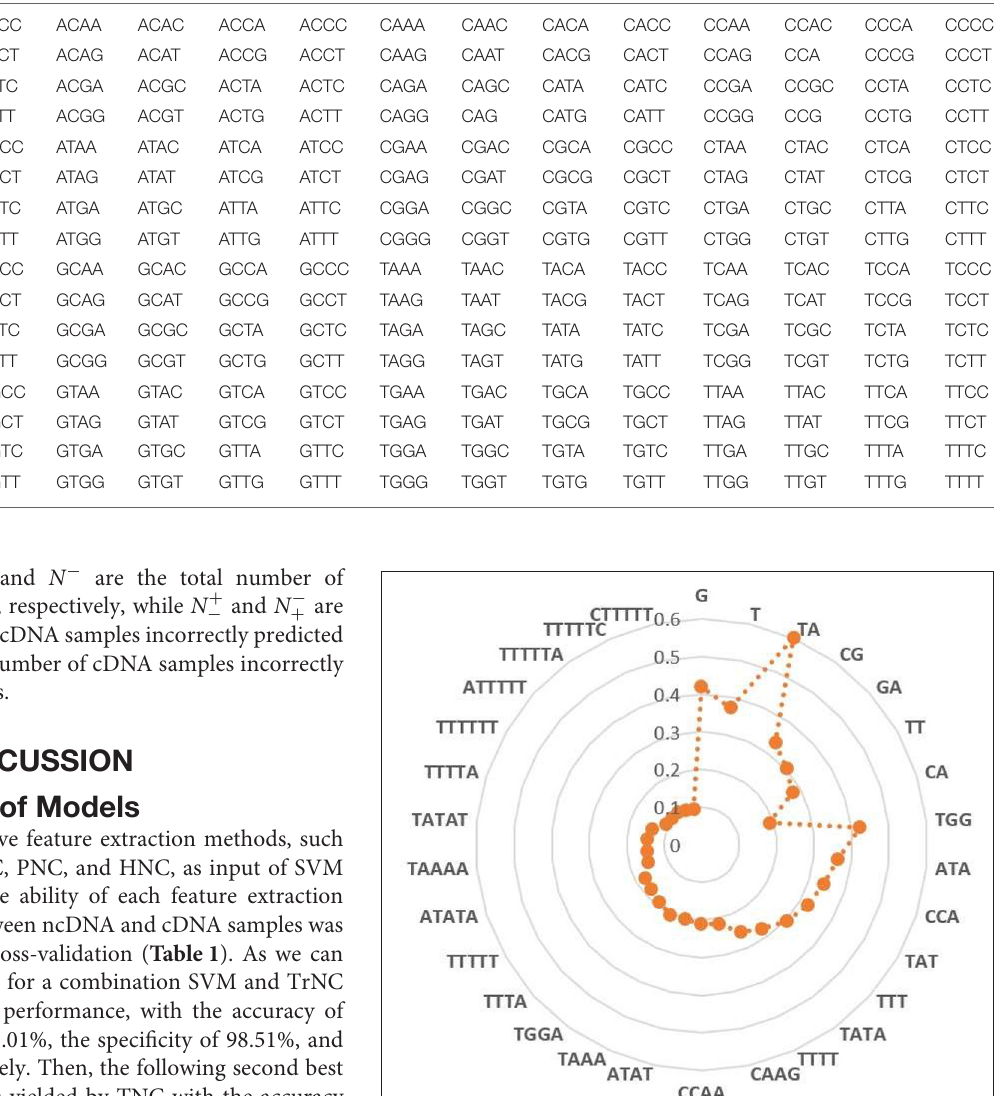
TABLE 2 | Rules of composition of heat map.